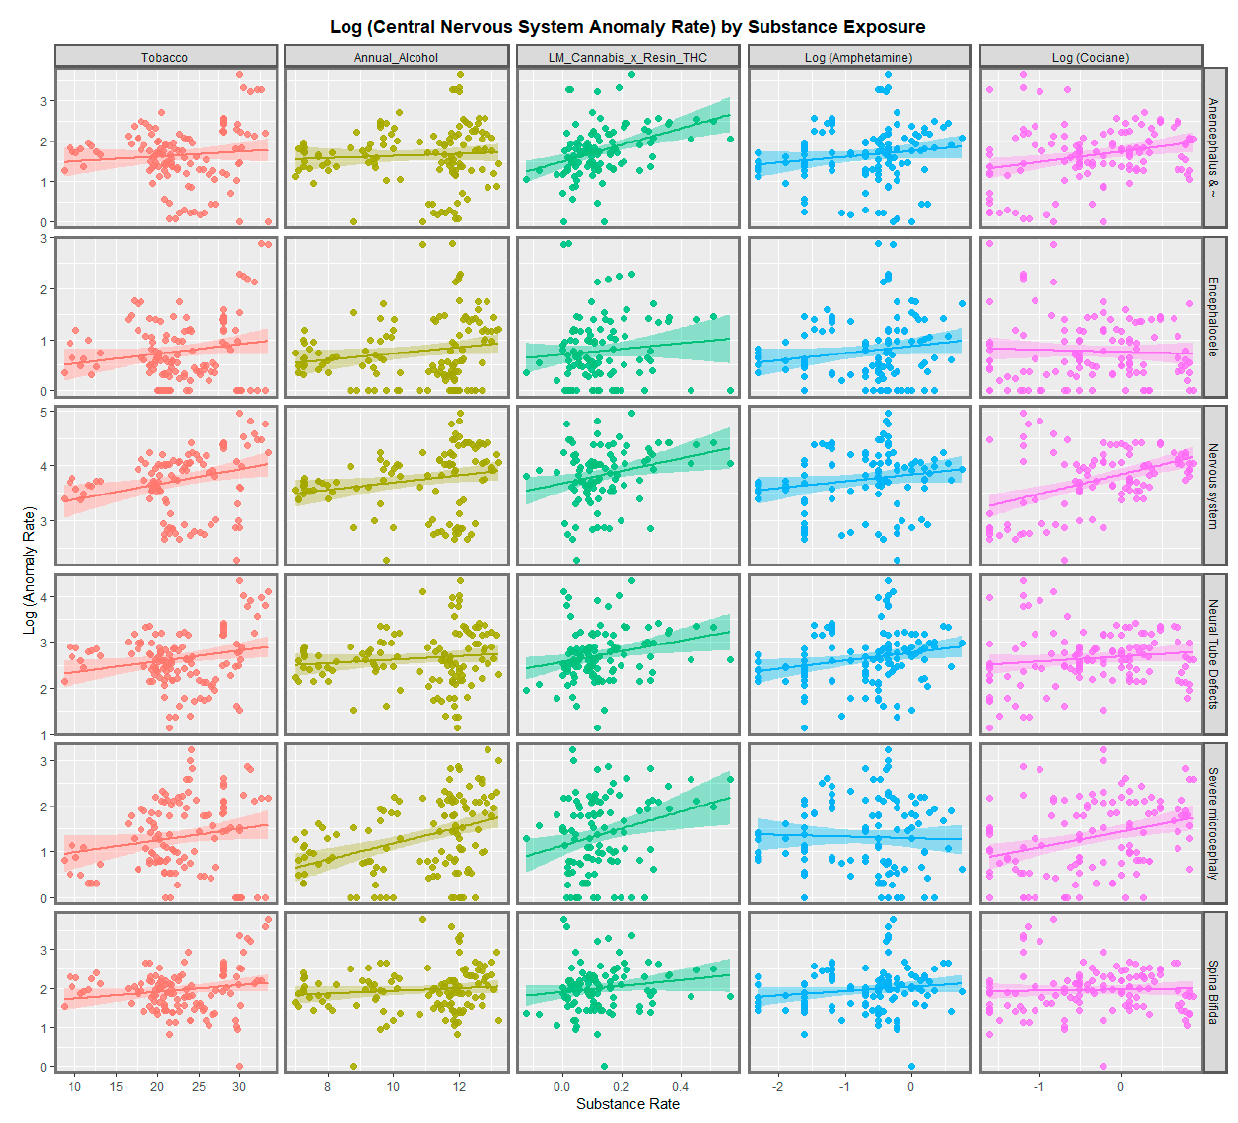
Figure 1. Paneled scatterplots for log (central nervous system congenital anomaly rates) by substance exposure rates for selected anomalies-1.